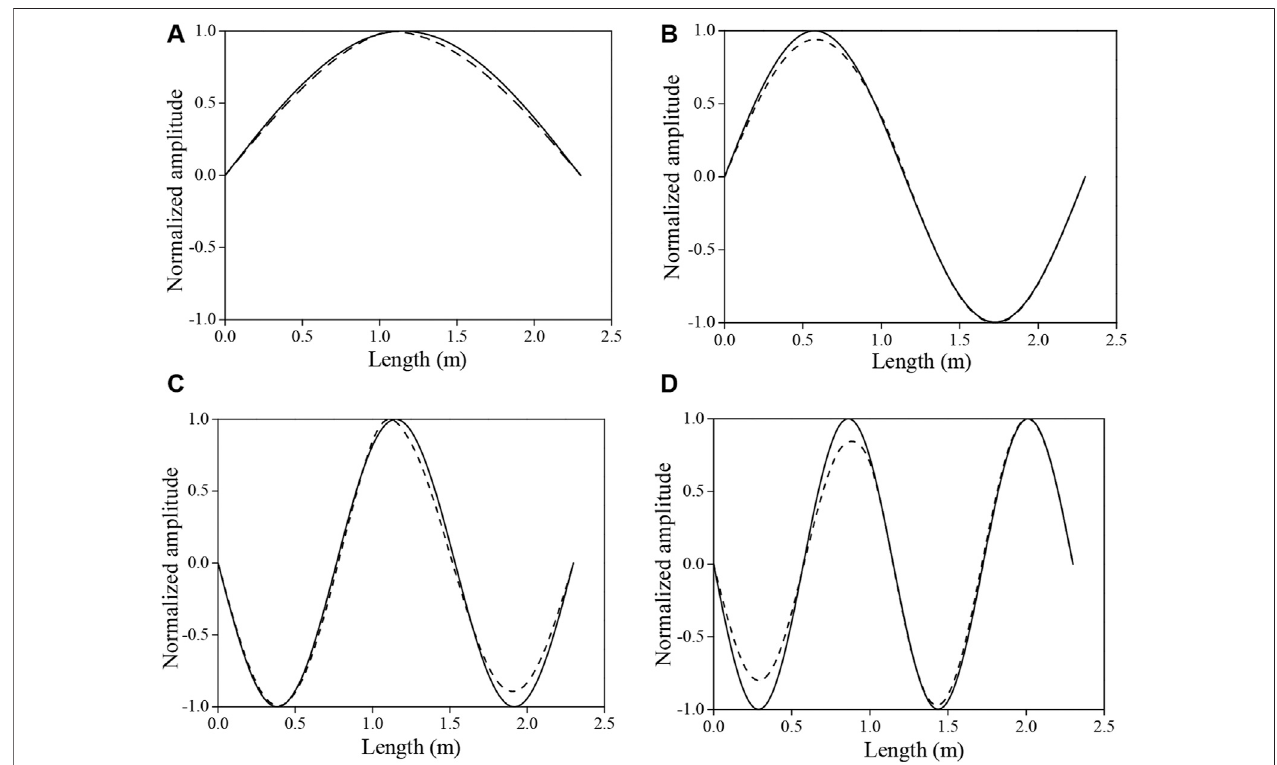
FIGURE14| FirstfourmodeshapesofBG1ofintact(solidline)anddamaged(dashline)scenarios. (A) :The fi rstmode, (B) :Thesecondmode, (C) :Thethirdmode, (D) : The fourth mode.